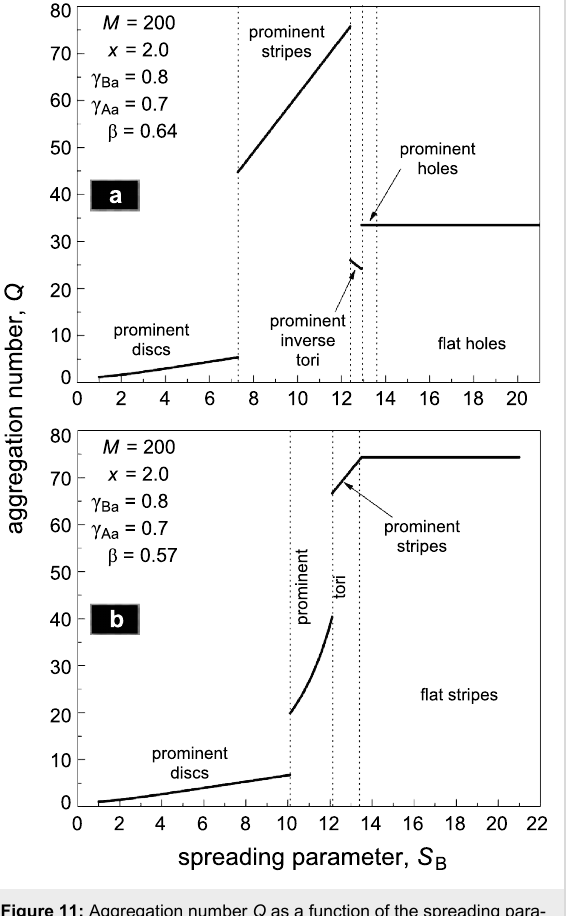
Figure 11: Aggregation number Q as a function of the spreading para- meter S B at different values of β : β = 0.64 (a) and 0.57 (b). The vertical lines split the regions of stability of various